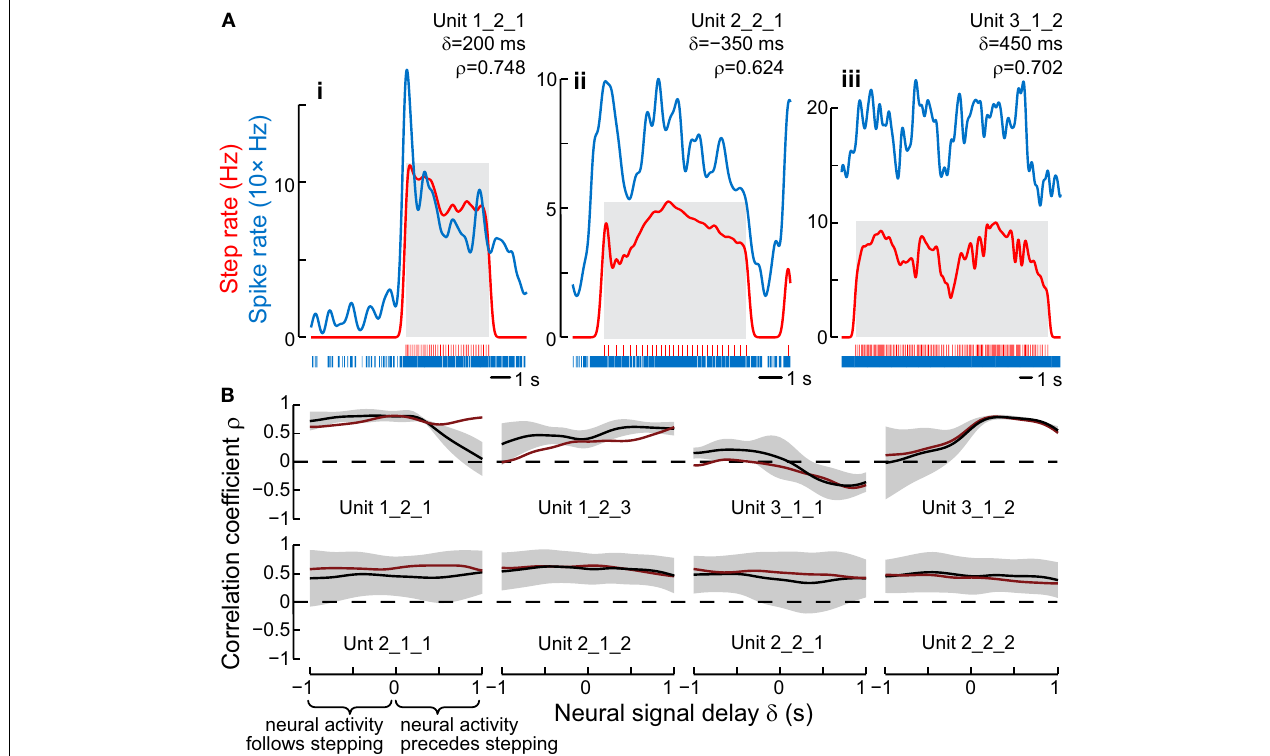
camera’s memory was filled. (B) The correlation coefficient ρ changed as the spike rate curve was shifted relative to the step rate curve.The black line shows the mean and SD envelope for ρ at each value of δ .These 8 units were the only ones with a peak average absolute value of the correlation coefficient (| ρ |) of at least 0.4.The top row shows units with a peak | ρ | at δ > 0, meaning that changes in spike rate usually preceded changes in step rate.The units in the bottom row had flat curves with peaks at δ < 0.The red lines show the mean ρ calculated after removing the first 1s of each walking bout to eliminate possible artifacts of antennal stimulation. From Bender et al.